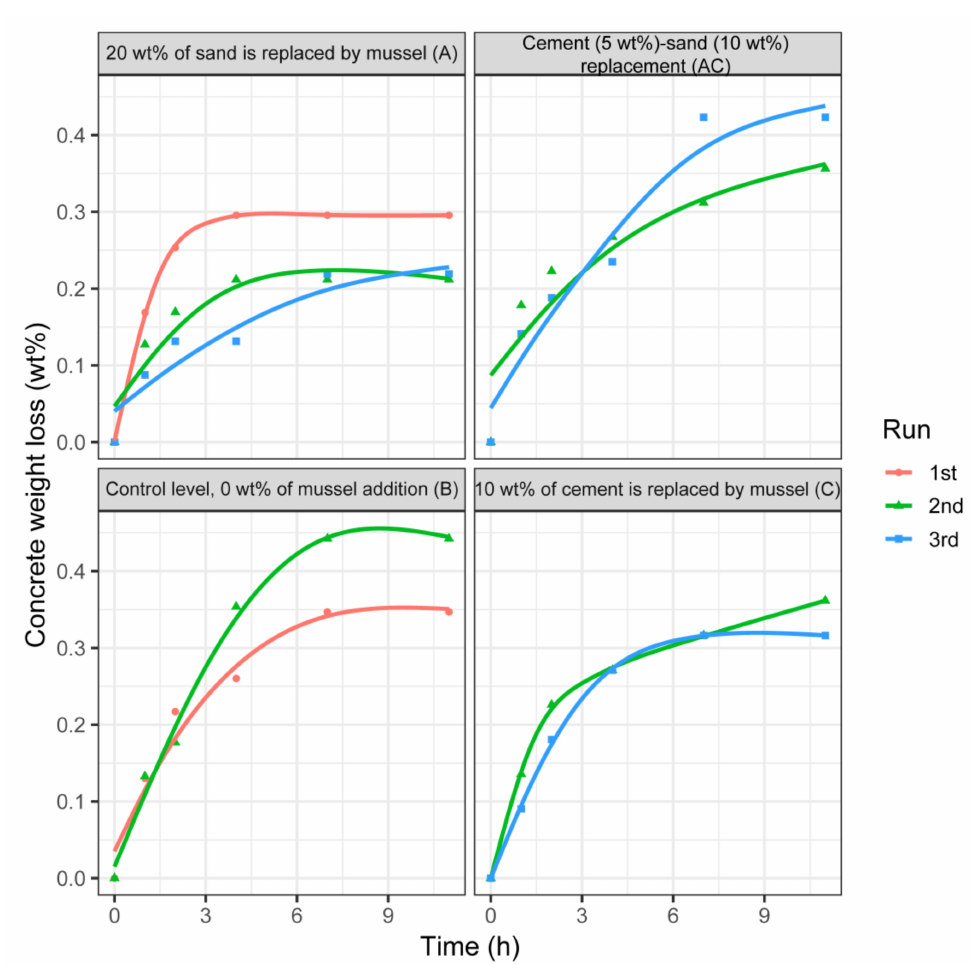
Figure 9. Degradation paths due to abrasive erosion of the different concrete formulations that are fitted by GAM